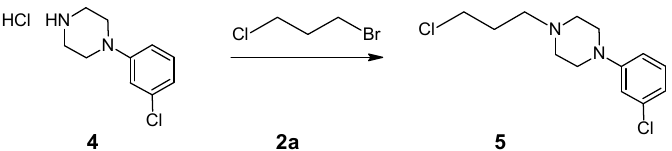
Table 2. Synthesis of trazodone with method I—10 mmol of 2-(3-chloropropyl)-1,2,4-triazolo[4,3-